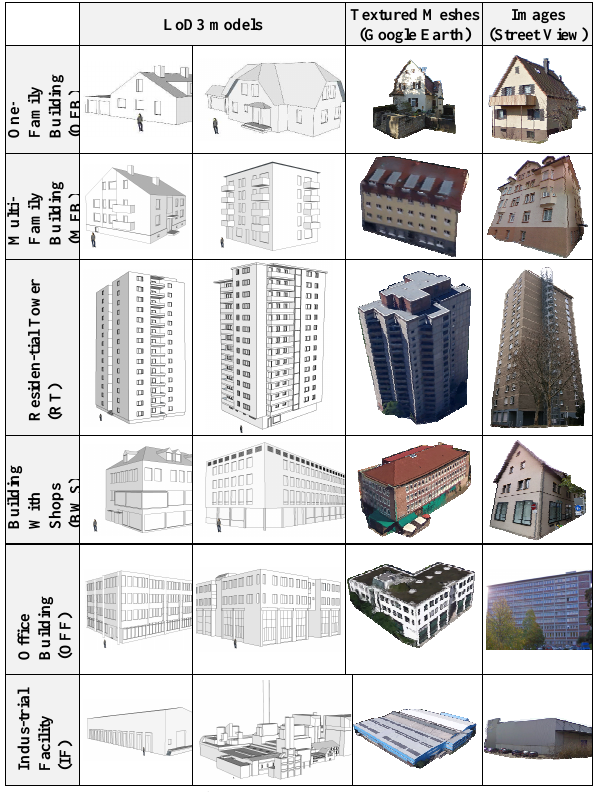
Figure 1. Examples for building categories and representation types used in the study (Google Earth/Street View, ©2015 Google) examples of the building categories and representation types presented to the